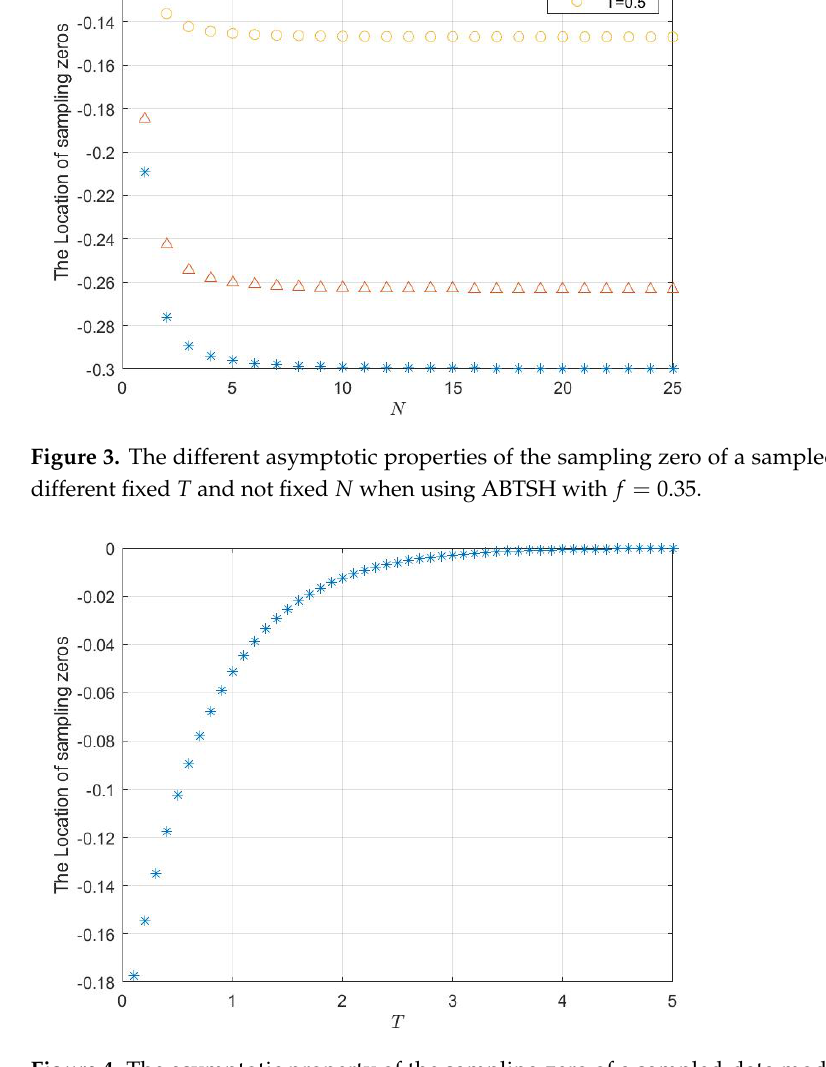
Figure 4. The asymptotic property of the sampling zero of a sampled-data model using AFTSH in the case of N = 2 and f =